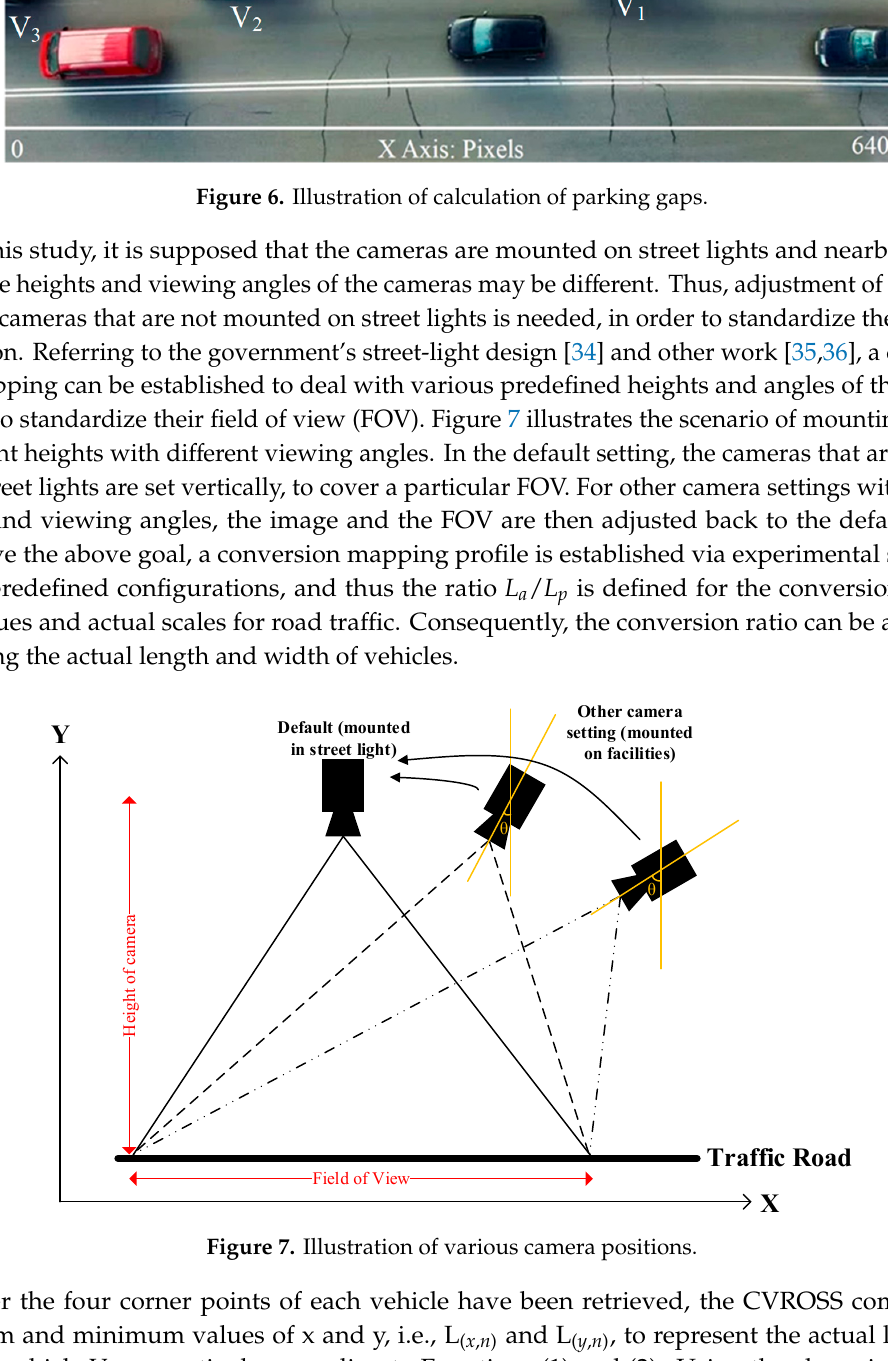
Figure 5. Overview of the computations in the CVROSS.